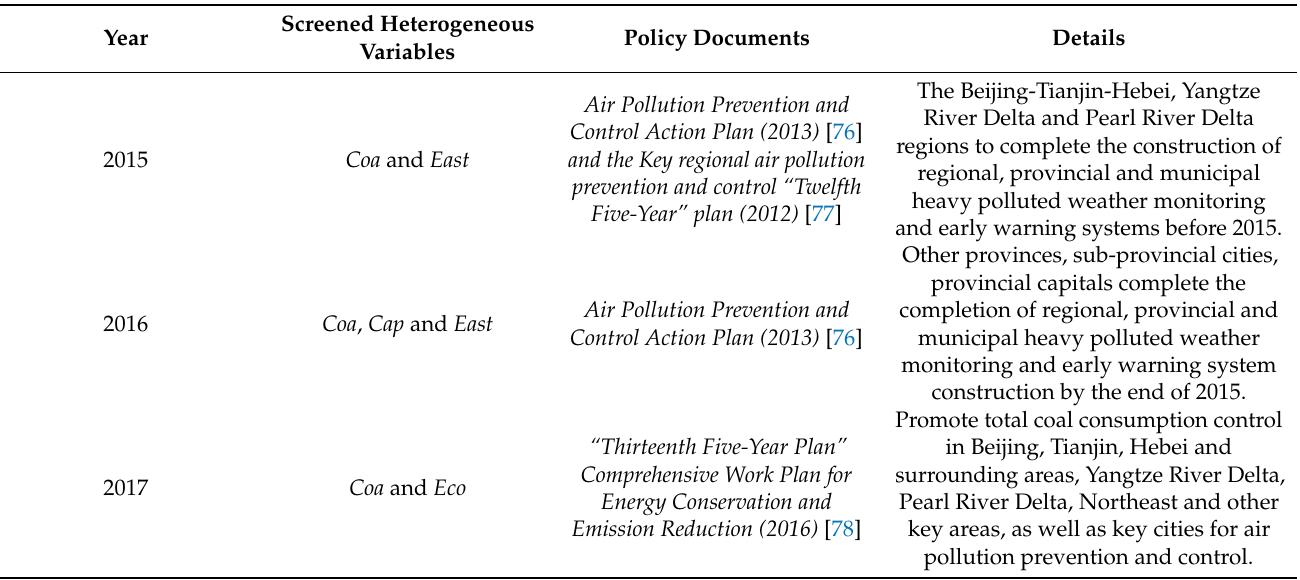
Table A2. The comparison of results with national policies.